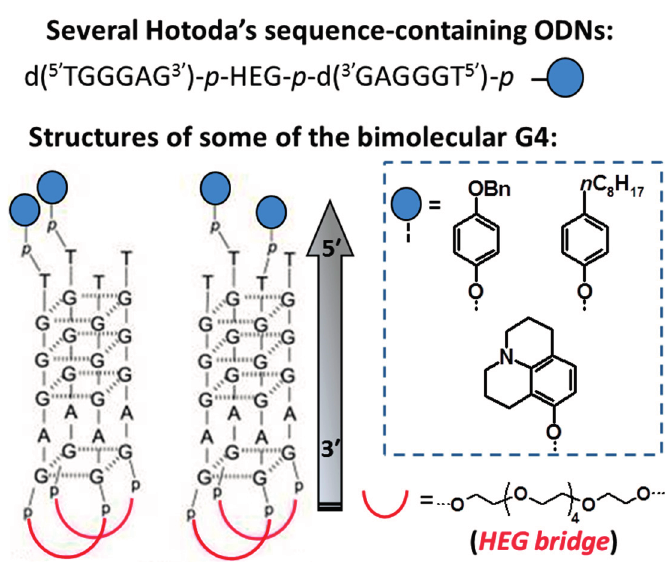
Figure 4. Some anti-HIV-1 ODNs forming bimolecular G4s with a HEG loop